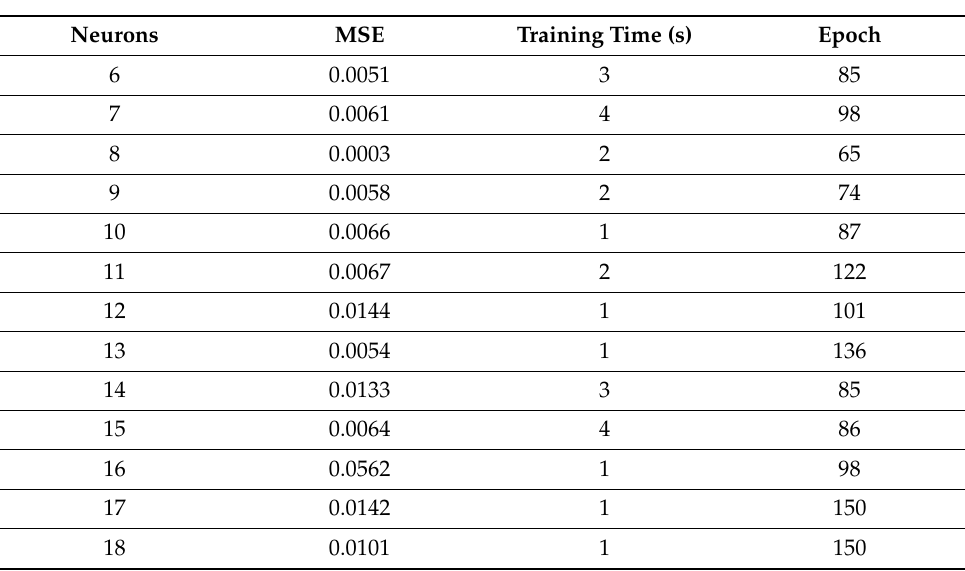
Table 8. Influence of the number of neurons in the hidden